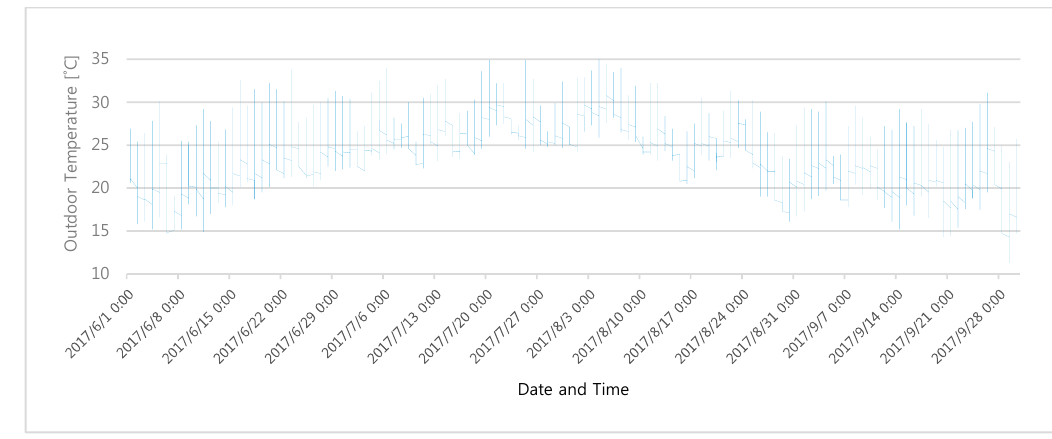
Figure 2. Average hourly demand for residential peak-time rebate (PTR) program customers in Seoul, Korea, from June through September.